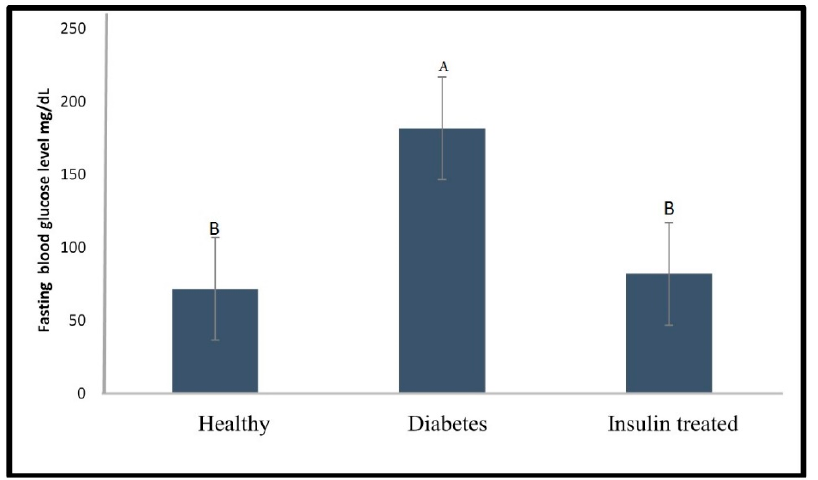
Figure 7. Fasting blood glucose level of healthy, diabetic, and insulin (1 U/kg) treated zebrafish. Different capital letter indicates significant difference ( p < 0.05) among the values, n =10.